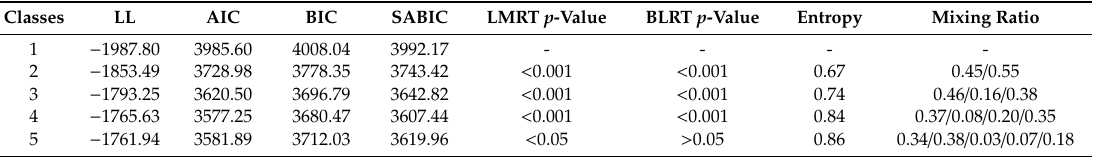
Table 2. Fit indices and class proportions for the 1 to 5 class